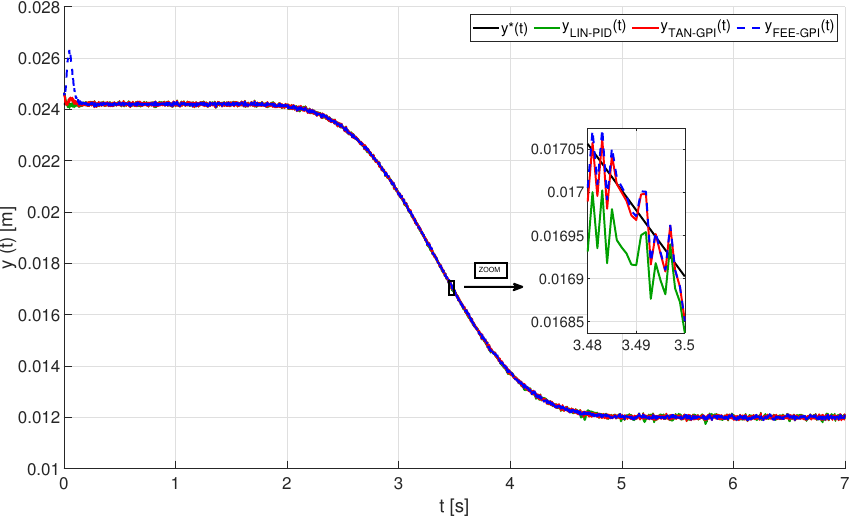
Figure 9. Evolution of the tracking trajectory of the magnetic ball, y ∗ ( t )[ m ] vs y ( t )[ m ] , with measure- ment noises and controller gain mismatches (Test 3).